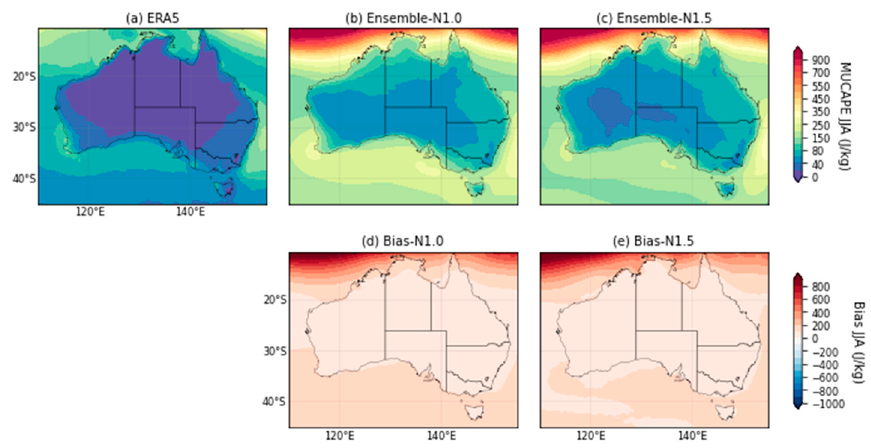
Figure A5. As in Figure A3 except for MAM.